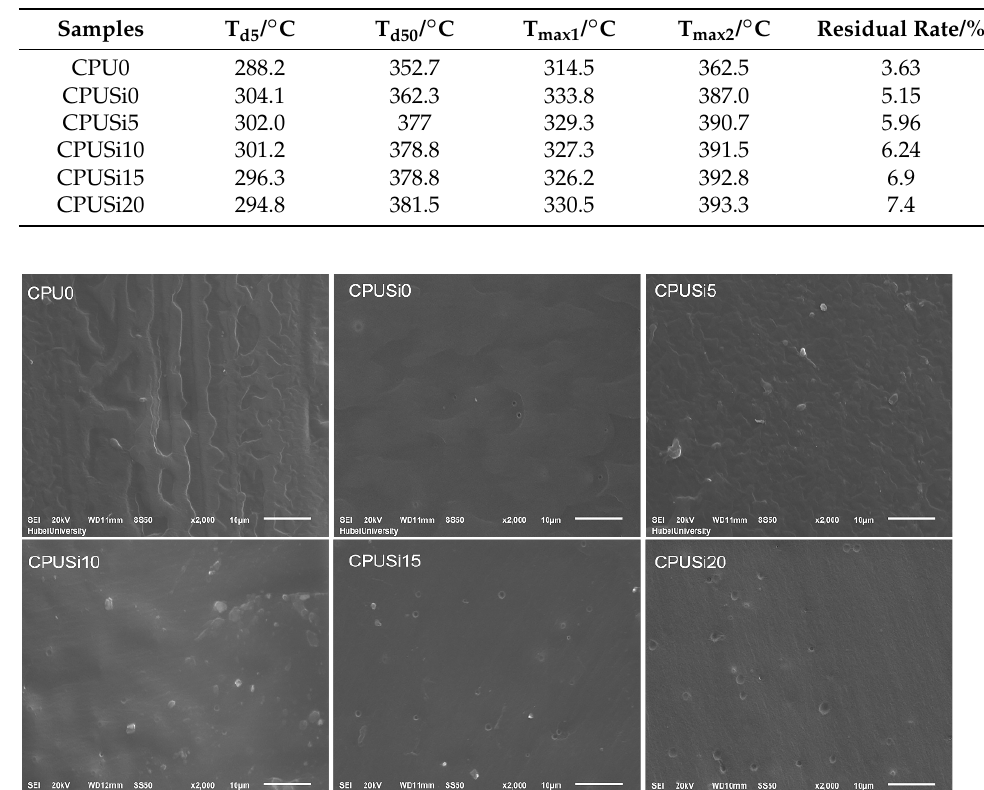
Figure 5. The morphologies of sections in CPU and CPUSi hybrids